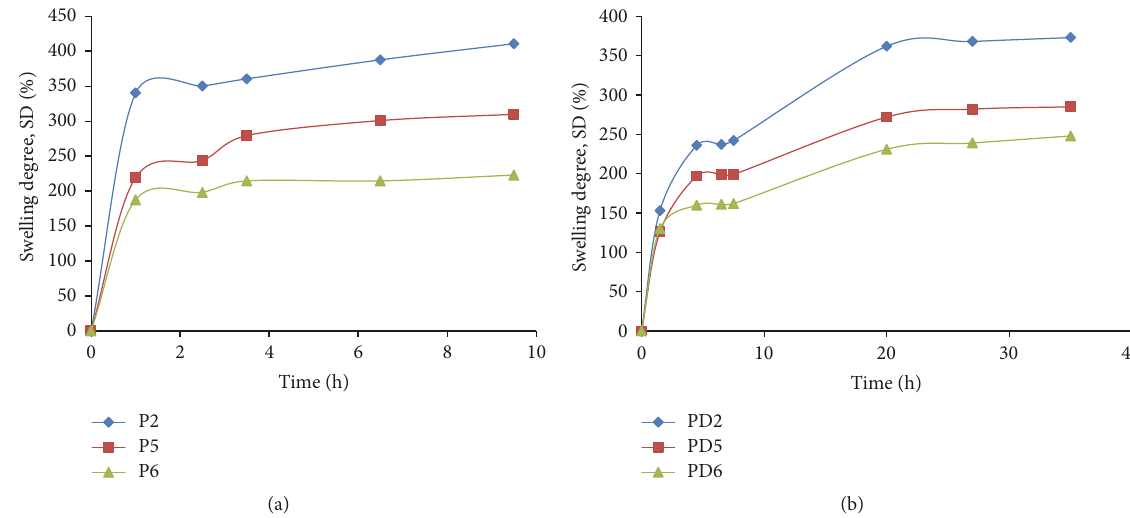
Figure 4: Variation of the swelling degree, in water, in time for gellan particles without (a) and with (b) yeast cells obtained in different extrusion